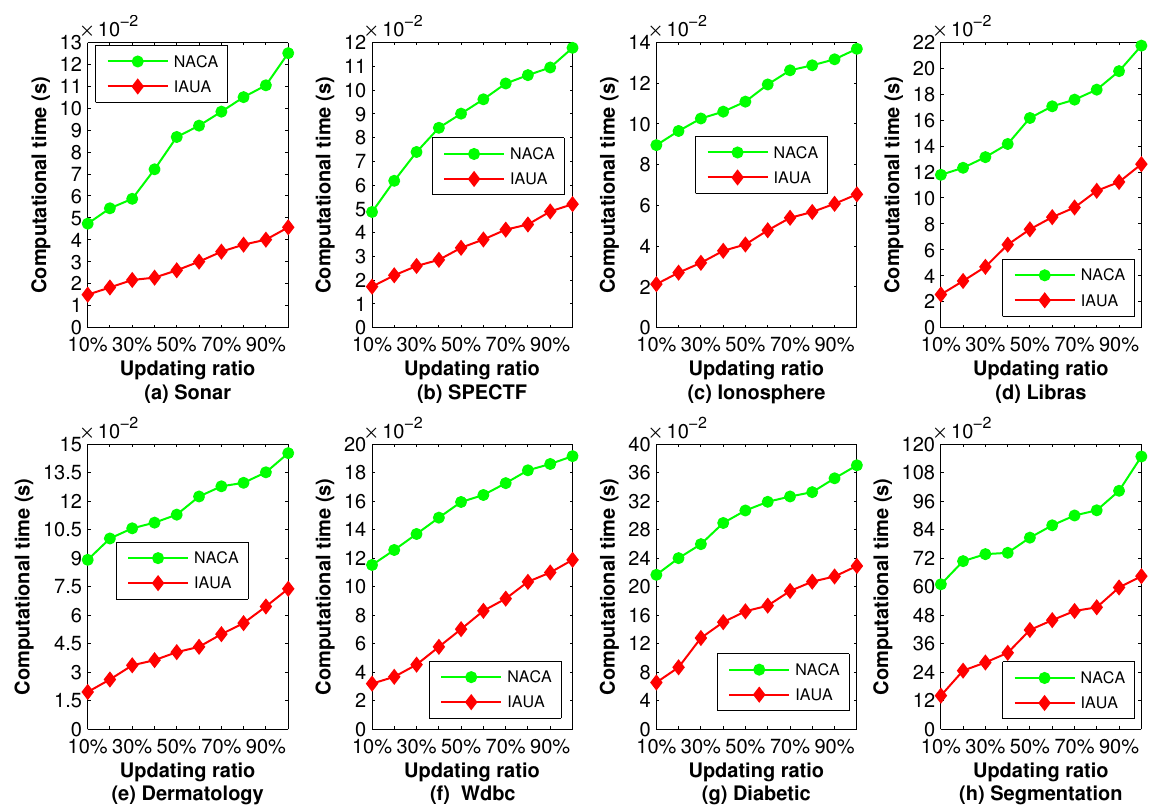
Figure 2. A comparison of NACA and IAUA with different updating